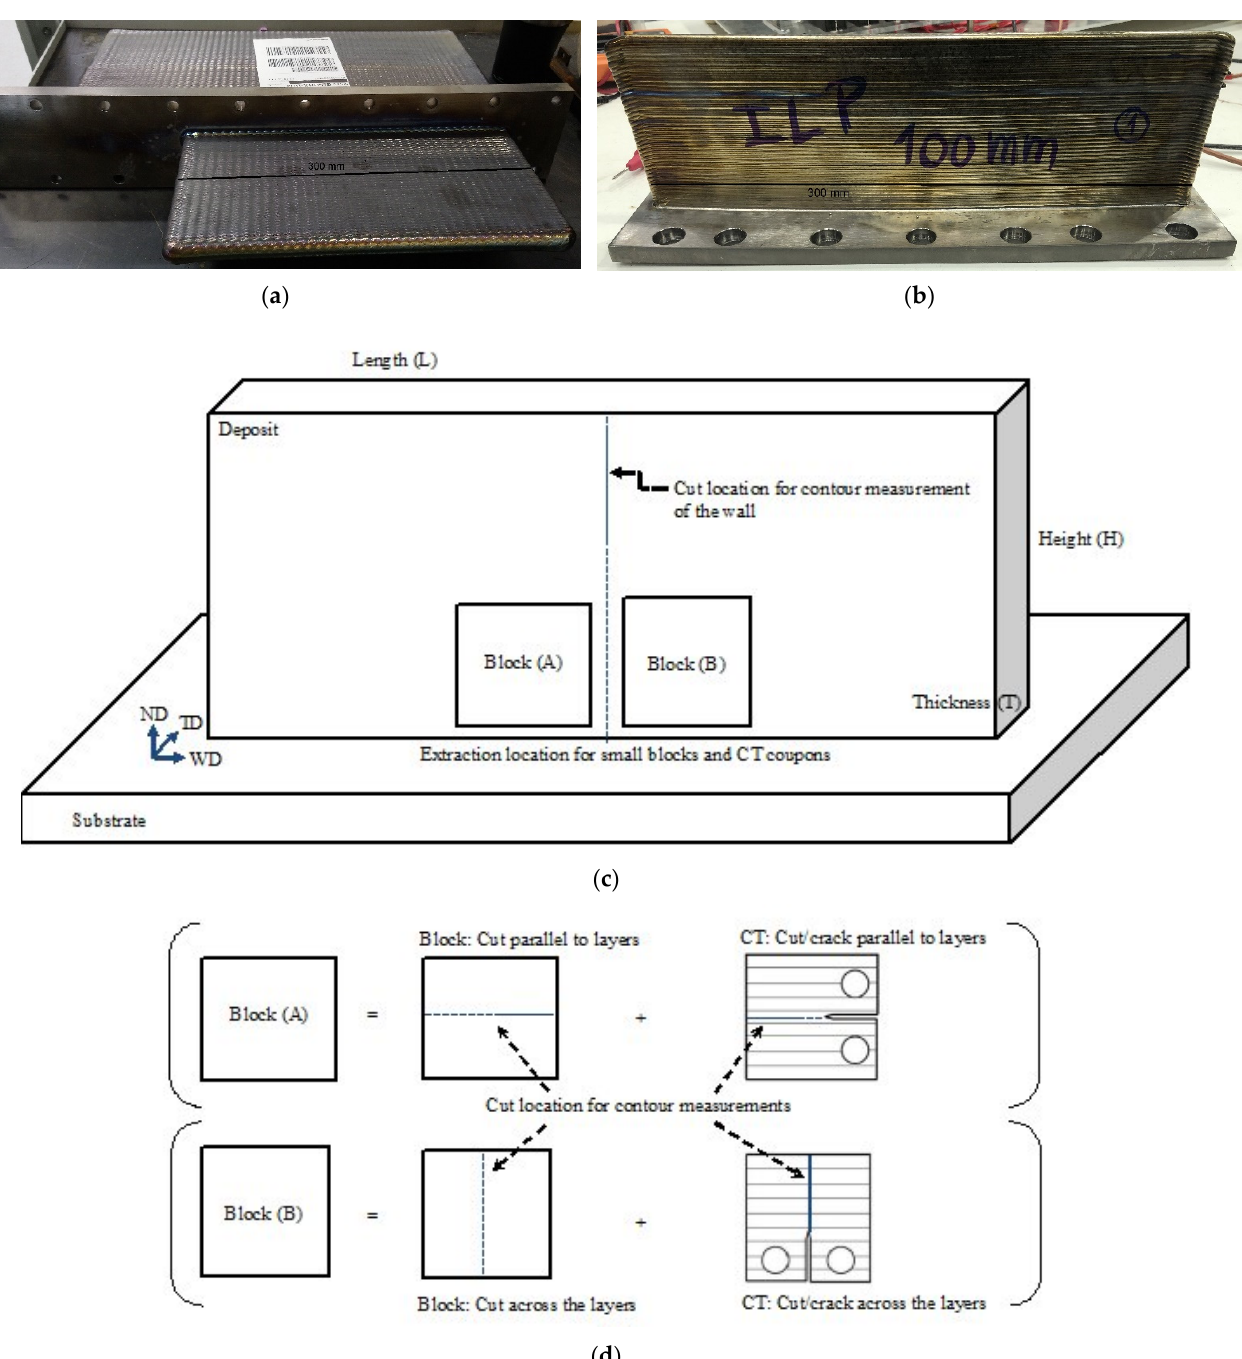
Figure 2. WAAM walls ( a ) oscillation path, ( b ) single bead with interlayer hammer peening, ( c ) sketch showing contour cut location on walls and extraction location of C(T) coupons, ( d ) sketch depicting contour cut and crack orientations for small blocks and C(T) coupons. The measured perimeter of various walls (single bead, parallel path, and oscillation path) at the mid-length is illustrated in Figure 3.